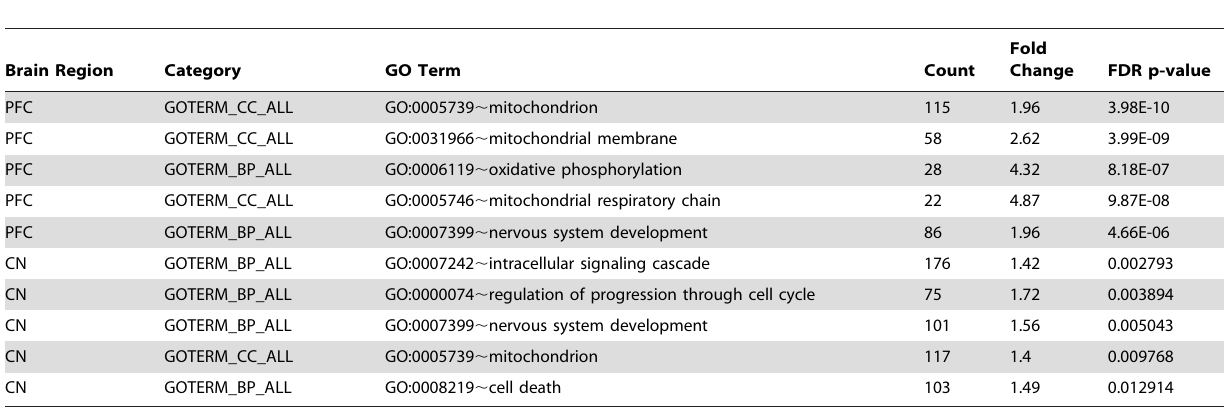
Table 1. Enriched biological pathways in the genes showing age-dependent changes in the PFC and the CN of normal individuals.